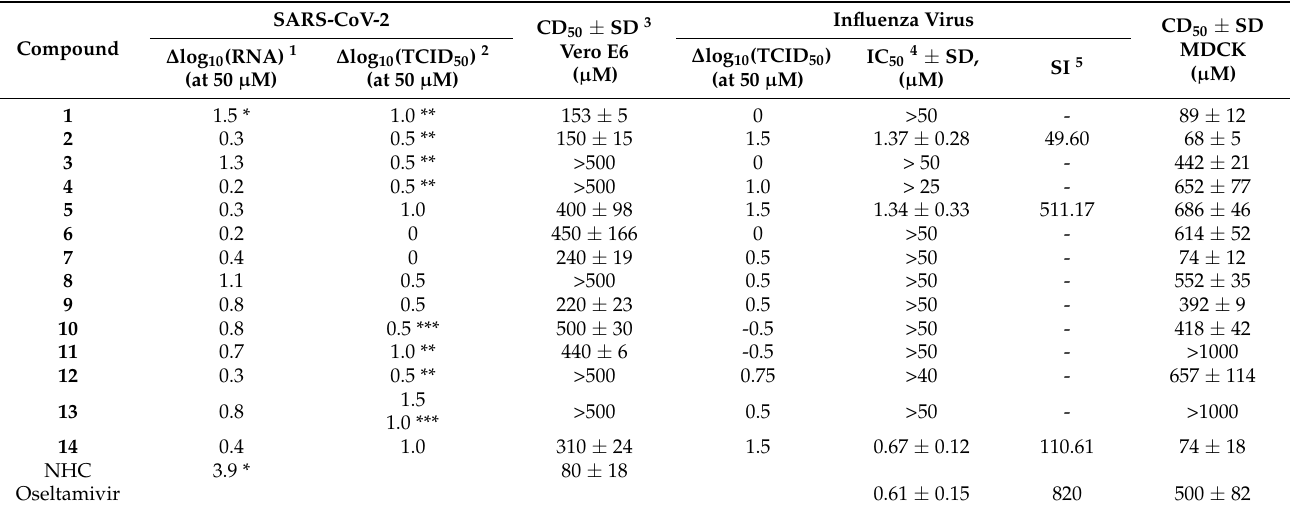
Table 1. Antiviral properties of compounds 1 – 14